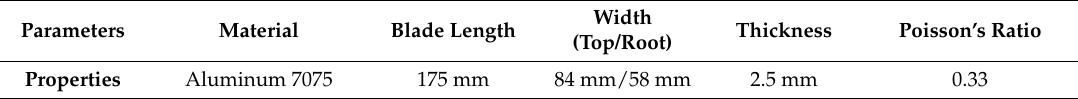
Figure 2. Blade modeling and meshing. ( a ) Flawless state; ( b ) Blade tip crack; ( c ) Blade middle crack; and ( d ) Blade root crack.